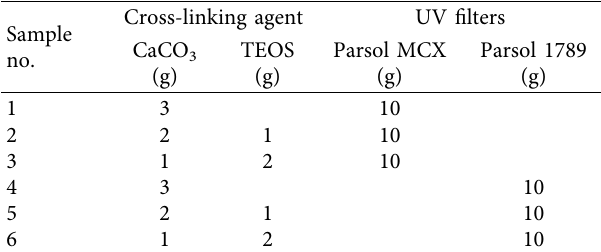
Table 1: Compositions of octyl methoxycinnamate microcapsules and butyl methoxydibenzoylmethane microcapsules. Cross-linking Sample no.